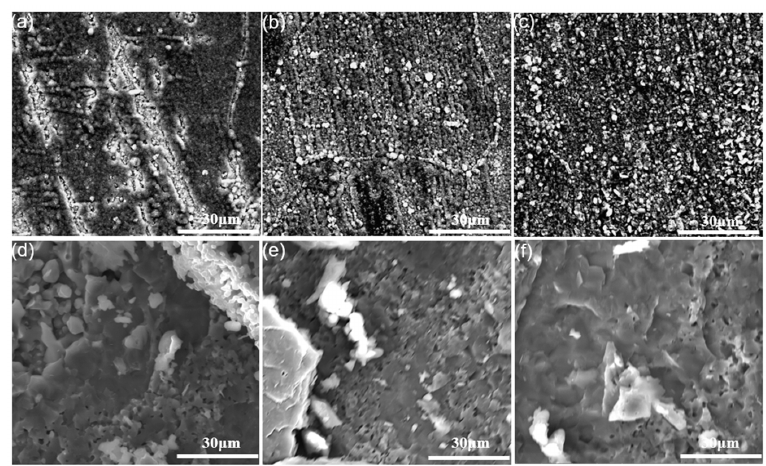
Figure 10. Surface morphology of alloys after oxidation for 100 h at 700 and 1000 °C: ( a,d ) 0 ° sample; ( b,e ) 55 ° sample; ( c,f ) 90 ° sample. Materials 2018 , 11 , x FOR PEER REVIEW